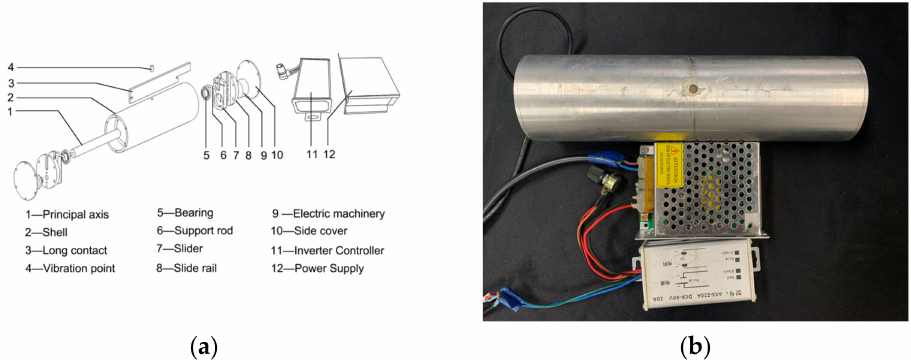
Figure 2. Single-point vibration signal generator. ( a ) Structure of the single-point vibration signal generator. ( b ) Photo of the single-point vibration signal generator.